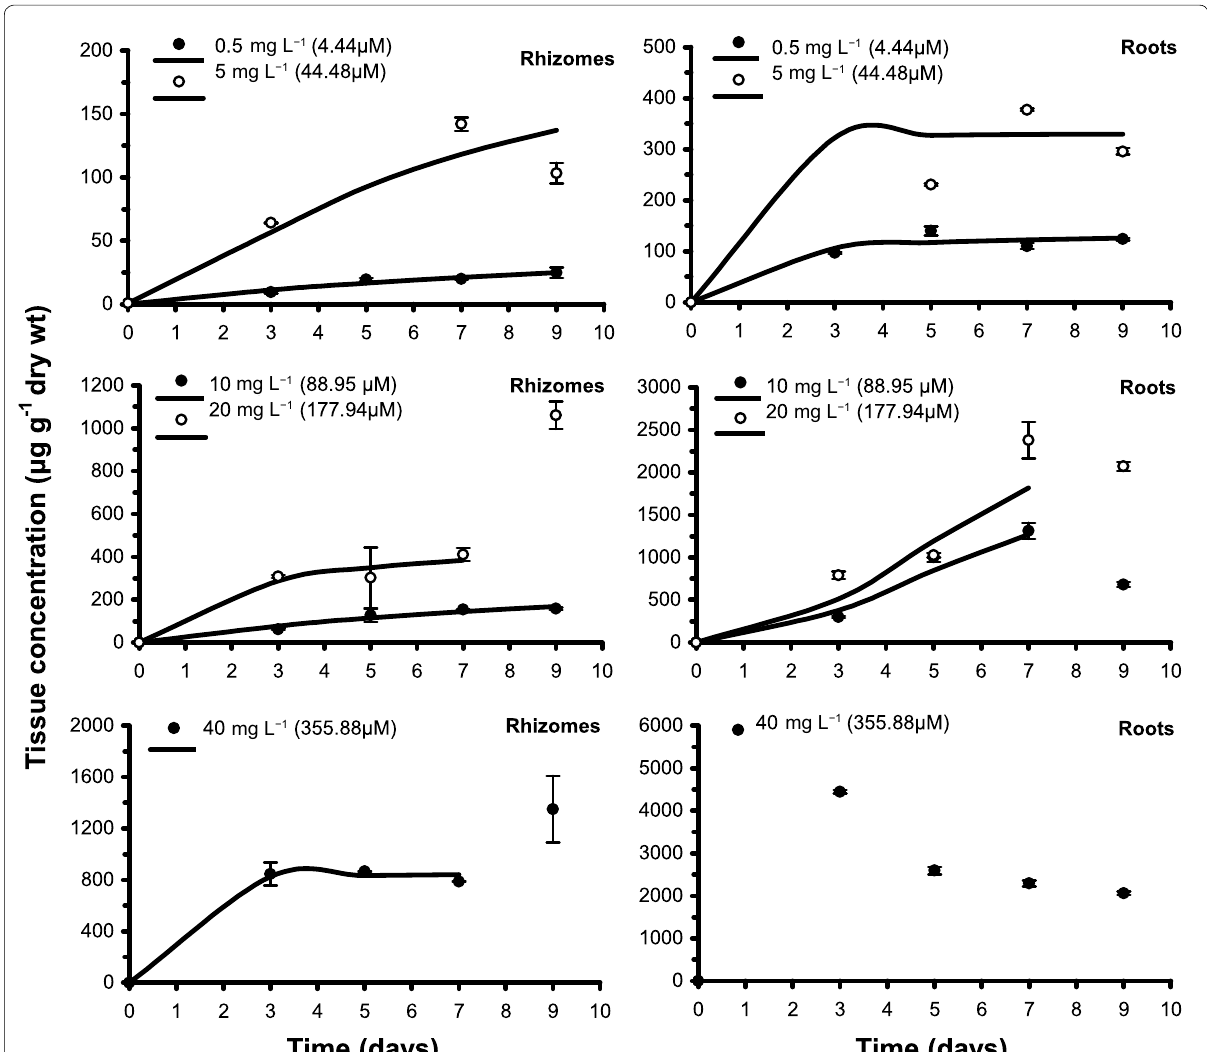
Fig. 2 Kinetics of cadmium accumulation in rhizomes and roots of Cymodocea nodosa at different concentrations of cadmium in water. Values plotted are mean tissue concentration standard error (n 3); bold lines are the accumulation kinetics calculated using a Michaelis–Menten‑ ± = type equation (rhizomes at 0.5, 10, 20 and 40 mg L − 1 and roots at 0.5 and 5 mg L − 1 ) or an S equation (rhizomes at 5 mg L − 1 and roots at 10 and 20 mg L − 1 )